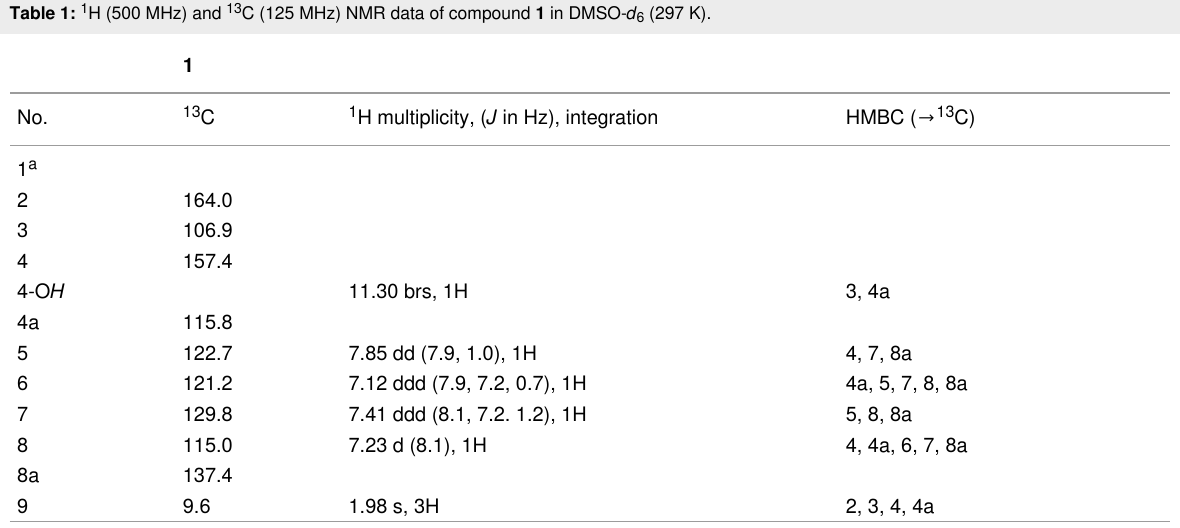
Table 1: 1 H (500 MHz) and 13 C (125 MHz) NMR data of compound 1 in DMSO- d 6 (297